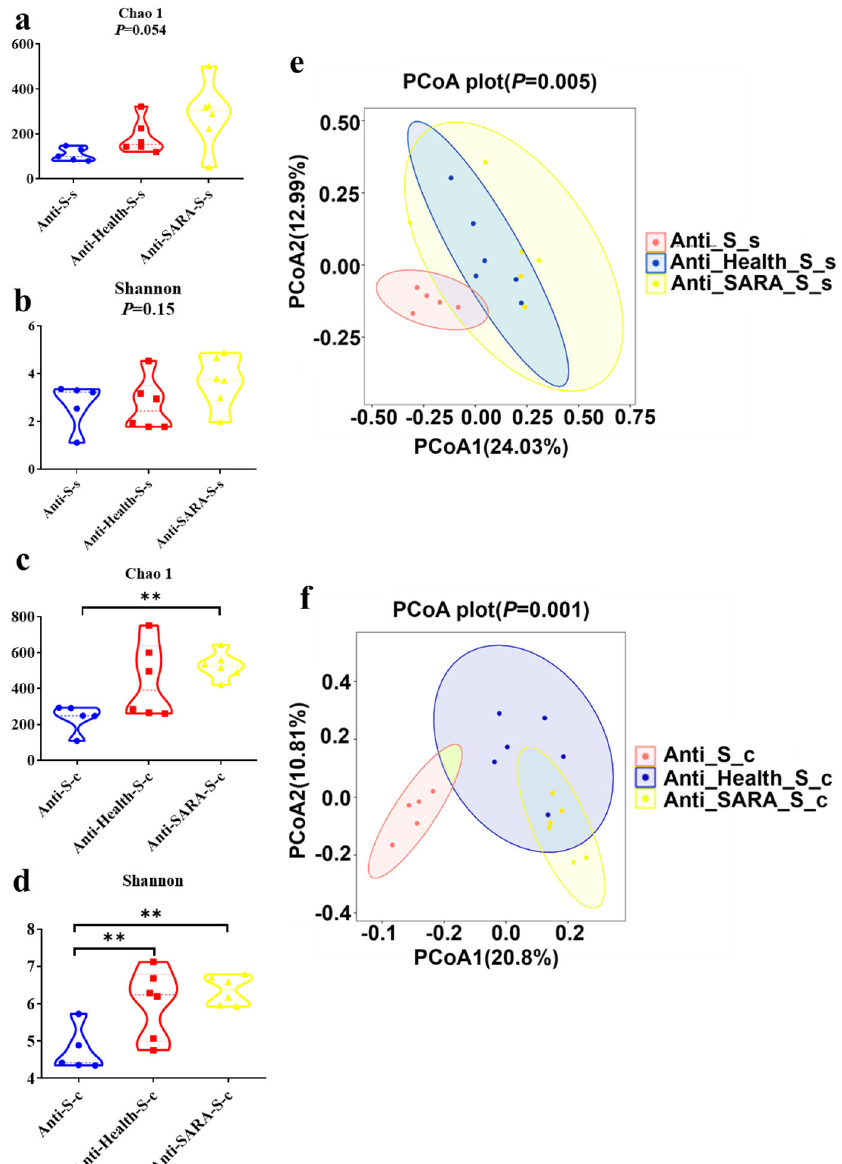
Fig. 5 Effects of ruminal microbe transplantation (RMT) on the intestinal microbial composition of antibiotic-treated mice. a The Chao 1 index and b the Shannon index of the small intestine bacterial community after antibiotic-treated mice RMT. c The Chao 1 index and d the Shannon index of the colonic bacterial community after RMT in antibiotic-treated mice. The data of ( a – d ) were statistically analyzed using the Kruskal-Wallis test with Dunn ’ s post-hoc test. e Principal Coordinates Analysis of the small intestine bacterial community after RMT in antibiotic-treated mice. f Principal Coordinates Analysis of the colonic bacterial community after RMT in antibiotic-treated mice. The data of ( e ) and ( f ) were statistically analyzed based on ANOSIM analysis. Anti: mice taking antibiotics; Health: mice infused by intragastric gavage with rumen fl uid from health dairy goats; SARA: mice infused by intragastric gavage with rumen fl uid from SARA dairy goats; S: high starch diet for mice; s: small intestine of mice; and c: mice colon. *Indicates the difference is at a signi fi cant level with p < 0.05, **indicates the difference is at a signi fi cant level with p <